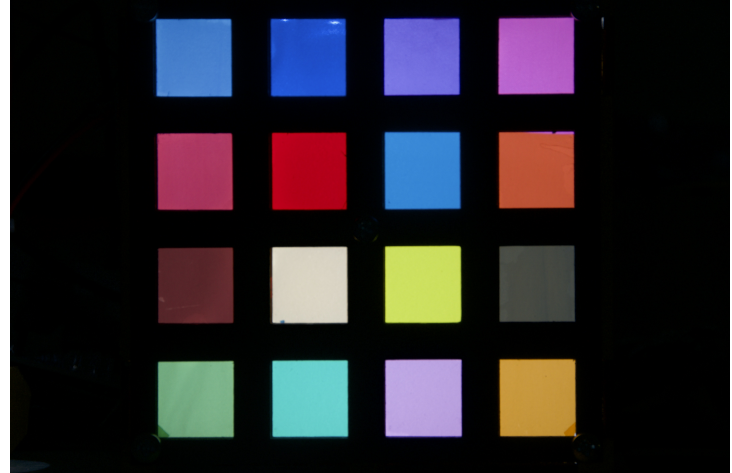
Figure 5. An example image of a color patch photo. The color patches are transmissive color filters used for filtering the light of camera flashes, illuminated from behind using a LED producing white light at correlated color temperature of 10,833 K.